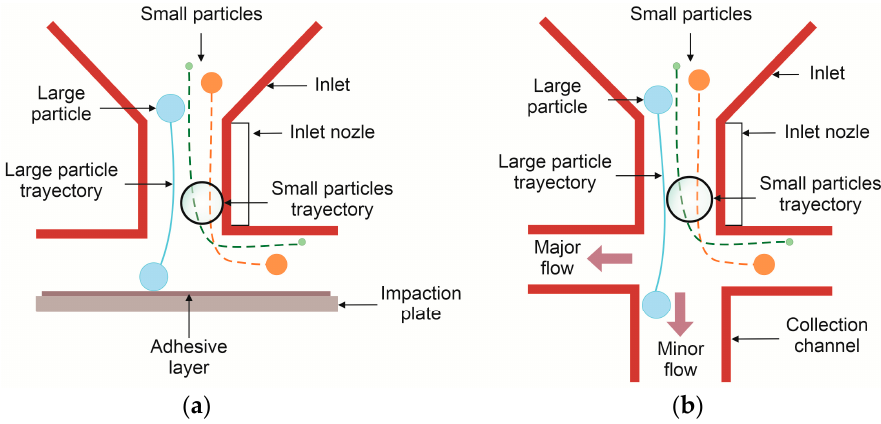
Figure 3. Operation principles of the ( a ) Cascade Impactor (CI) and ( b ) Virtual Impactor (VI). Unlike inertial microfluidics, the performance of the impactors is measured according to the Stk number at which the collection efficiency is 50% ( Stk 50 ) [71,81]. Therefore, if the Stk 50 value is known, the particle’s diameter for which the collection efficiency is 50% ( d 50 ) can be calculated, with this being the cut-off point mentioned above [71]. Assuming ideal conditions for an impactor meeting the design criteria established by Marple and Willeke [81], the optimal Stk 50 values for a rectangular and a circular nozzle are 0.59 and 0.24, respectively [82,83].